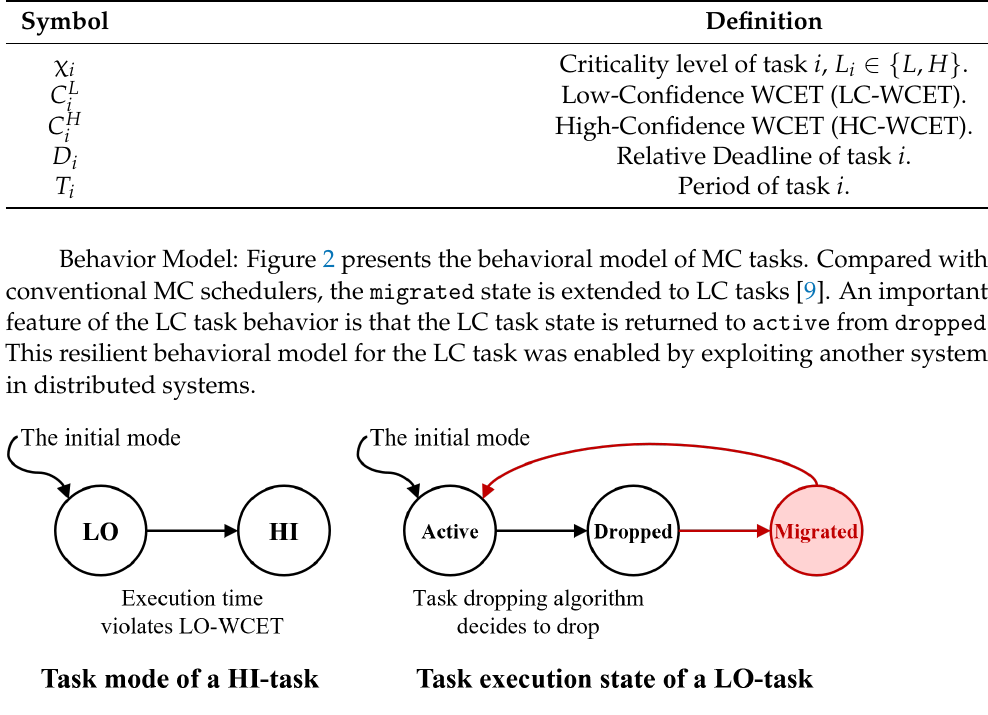
Figure 2. Extended behavioral model of tasks.